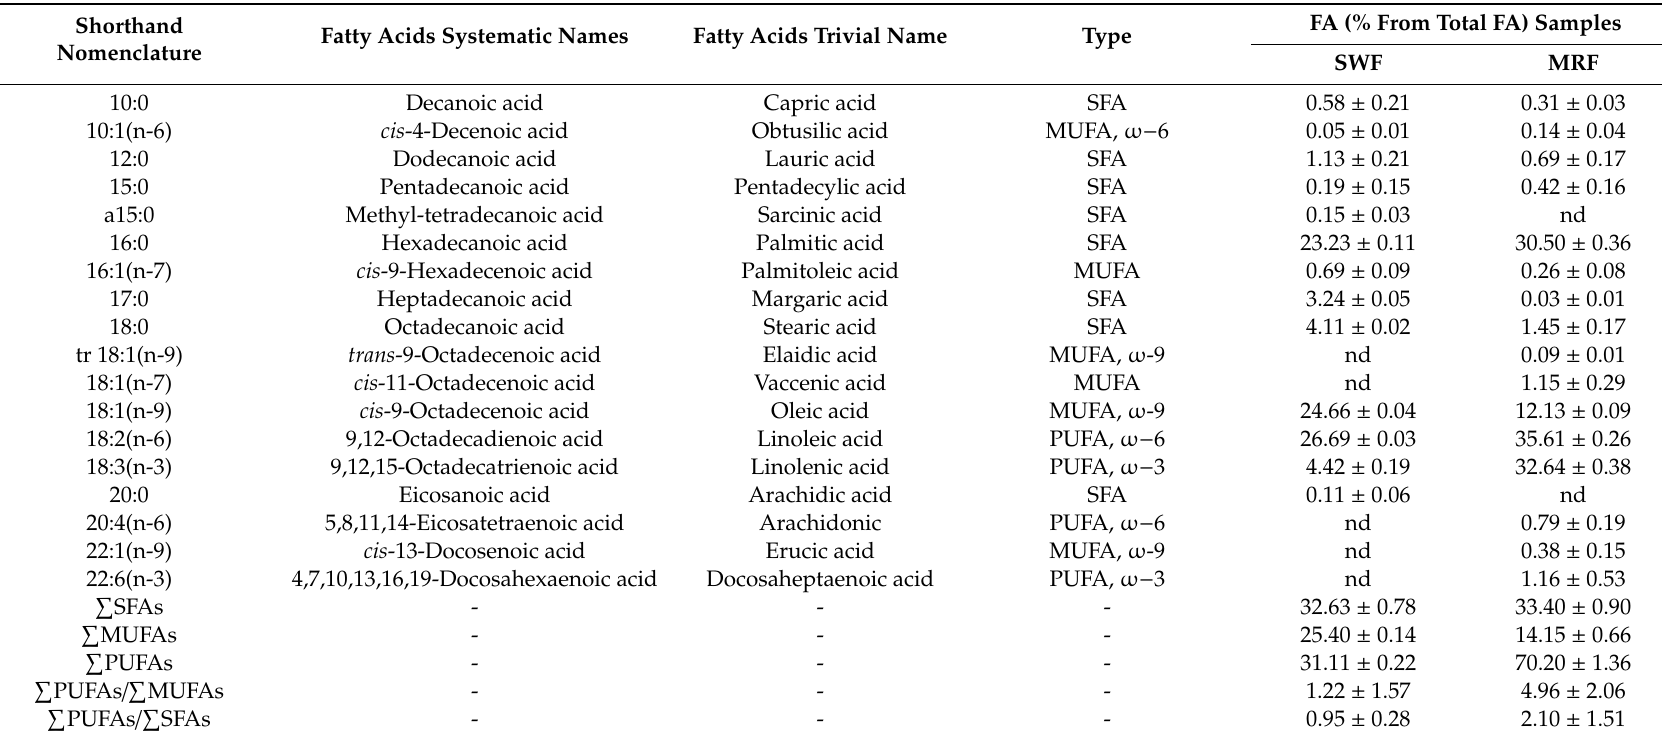
Table 2. Comparative fatty acids methyl esters content (% of total fatty acids methyl esters) of spent malt rootlets flour (MRF) and whole wheat spelt flour (SWF).